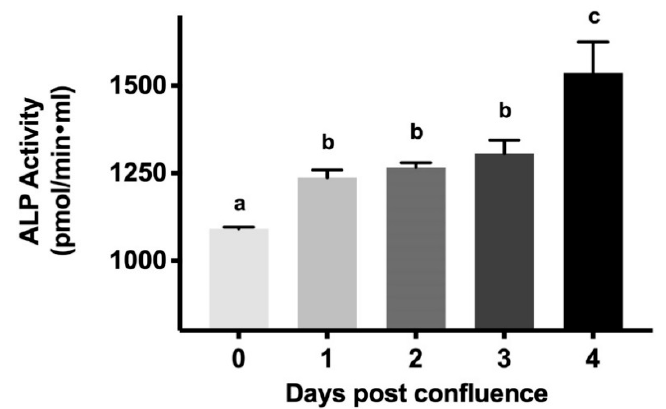
Figure 1. Alkaline phosphatase (ALP) activity to validate IEC-18 cell maturation. Values are represented as means ± standard error of the mean (SEM), n = 4. Values not sharing common superscripted letters are significantly different at p < 0.001.